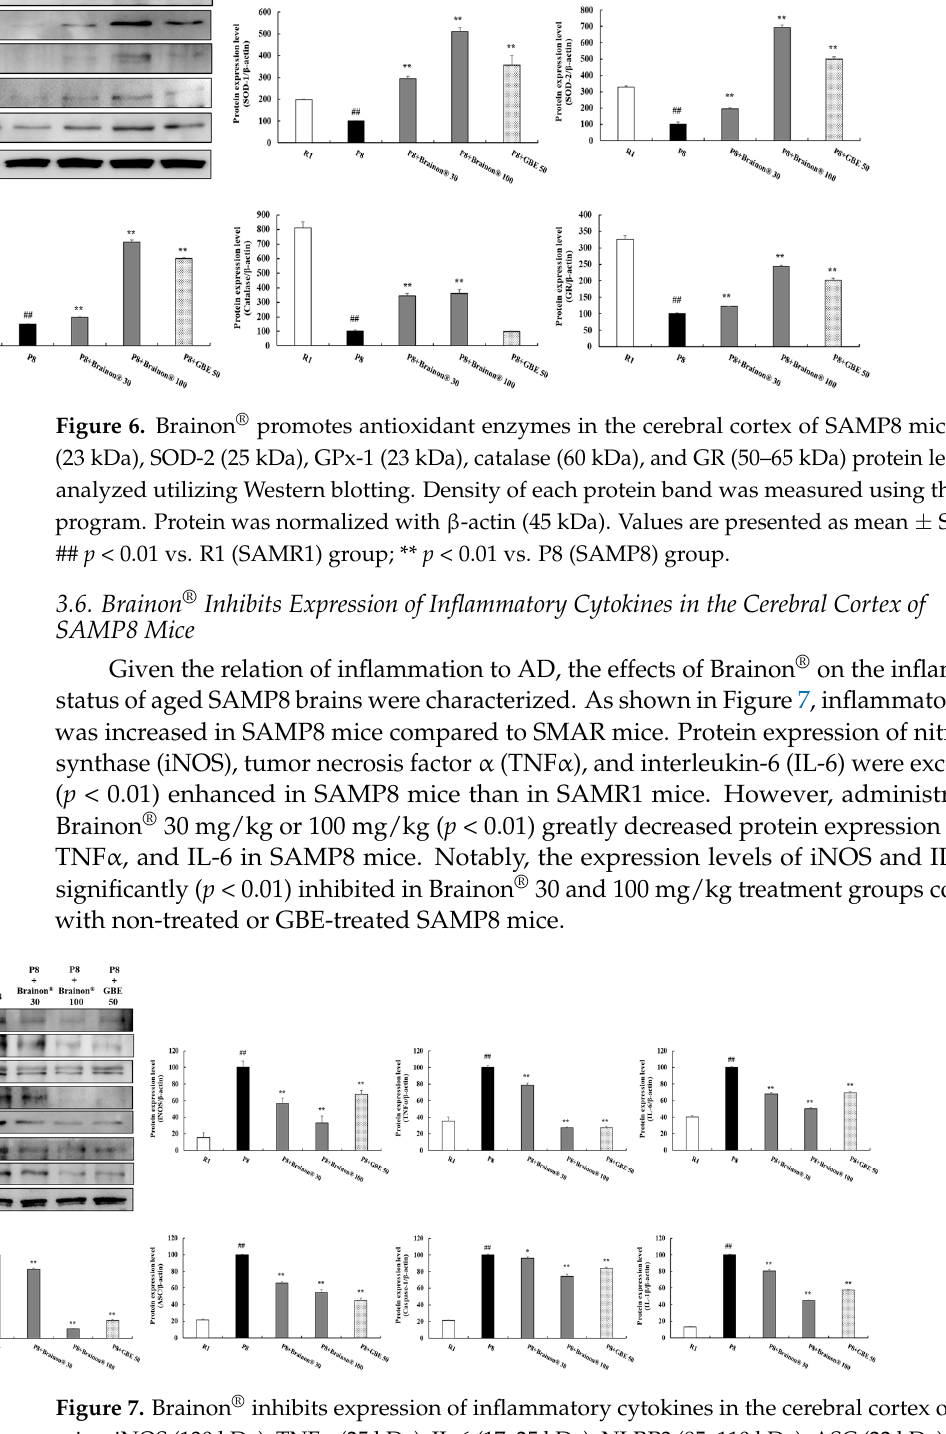
8 Figure 5. Effects of Brainon ® on inhibition of A β 1–42 production and hyperphosphorylation of Tau in the cerebral cortex of SAMP8 mice. BACE1 (70 kDa), A β 1–42 (4–46 kDa), p-Tau (50–80 kDa), and Tau (50–80 kDa) proteins were analyzed using Western blotting. The density of the protein band was measured using the ImageJ program. Protein was normalized with β -actin (45 kDa). Values are pre- sented as mean ± SD ( n = 3). ## p < 0.01 vs. R1 (SAMR1) group; ** p < 0.01 vs. P8 (SAMP8) group. 3.5. Brainon ® Promotes Antioxidant Enzymes in the Cerebral Cortex of SAMP8 Mice To assess the effects of Brainon ® on antioxidant enzymes in the cerebral cortex of SAMP8 mice, protein expression of superoxide dismutase-1 (SOD-1), SO D-2, glutathione peroxidase-1 (GPx-1), Catalase, and glutathione reductase (GR) were evaluated. Results